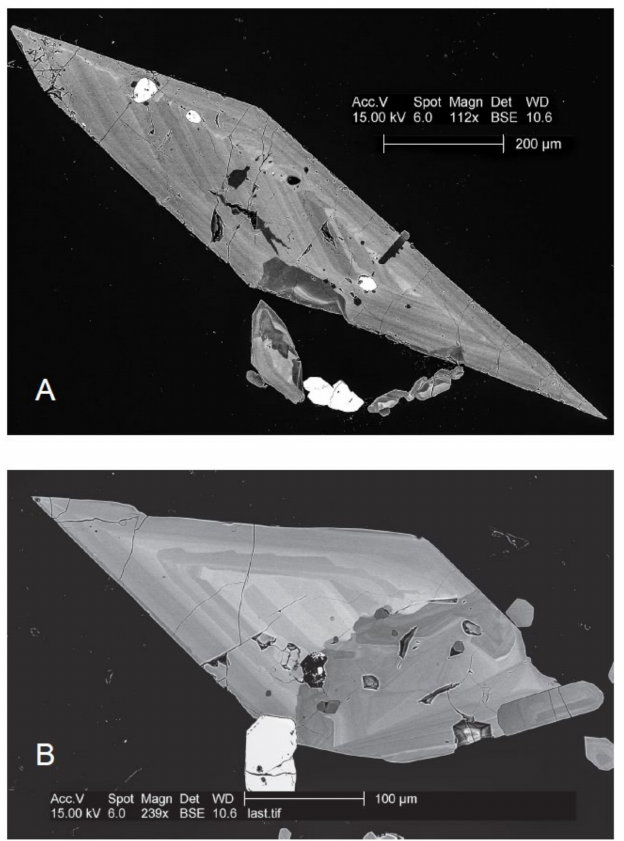
Figure 19. Backscattered electron (BSE) images of titanite from the Jurassic Notch Peak pluton, Utah. These grains have been partially recrystallized, probably as they interacted with a hydrothermal